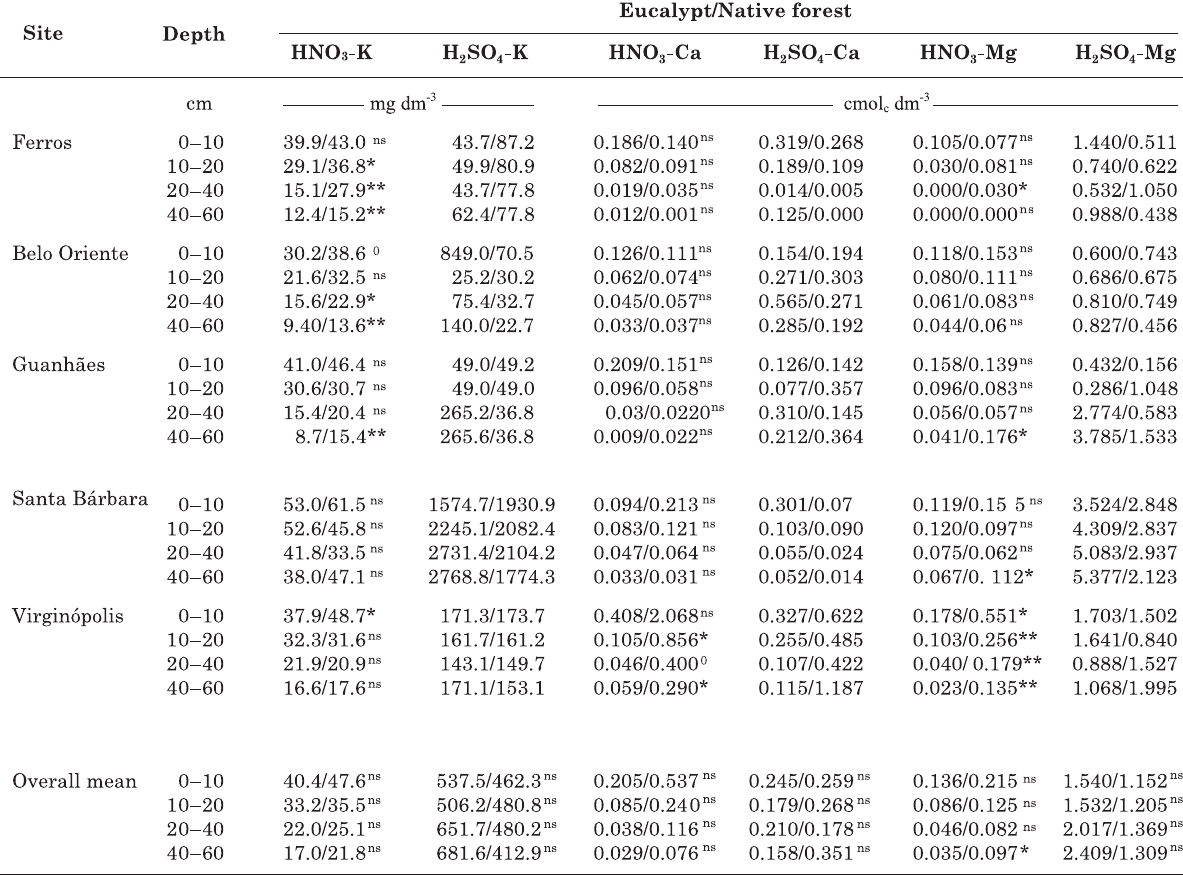
Table 6. Concentrations of available/exchangeable forms and the intermediate availability (extracted with HNO ) and “stable” forms (extracted by sulfuric acid) of K, Ca, and Mg in soil samples at different 3 depths of eucalyptus or native forest in five areas of the Rio Doce Valley region with their respective significance of contrast